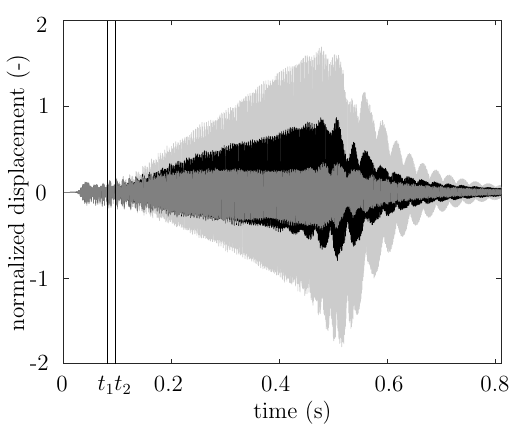
Figure 12. Time evolution of the blade displacement at the leading edge ( ), mid-chord ( ), and trailing edge ( ) for the HP compressor test